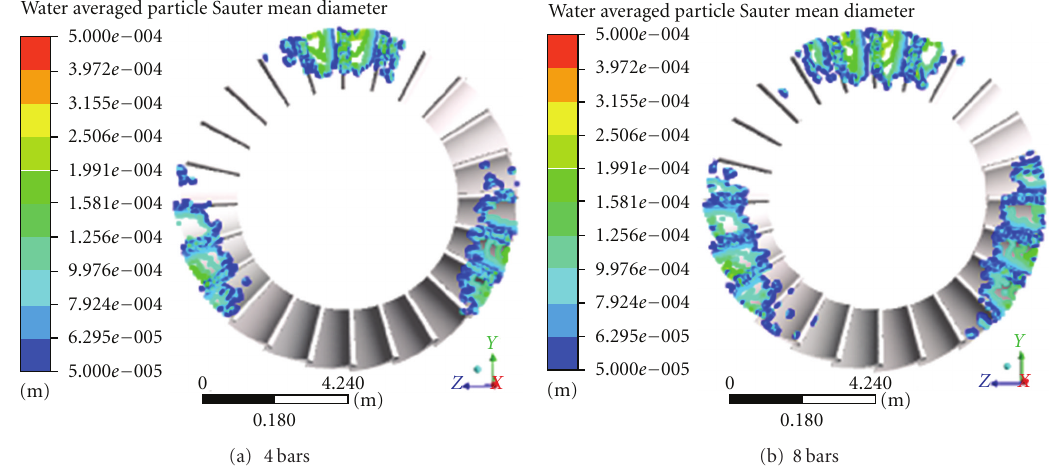
Figure 3: Numerical predicted water droplet size and its distributions on the blade surface at a loading speed of 900 rpm/T ∧ 0.5 and 30 ◦ water nozzle